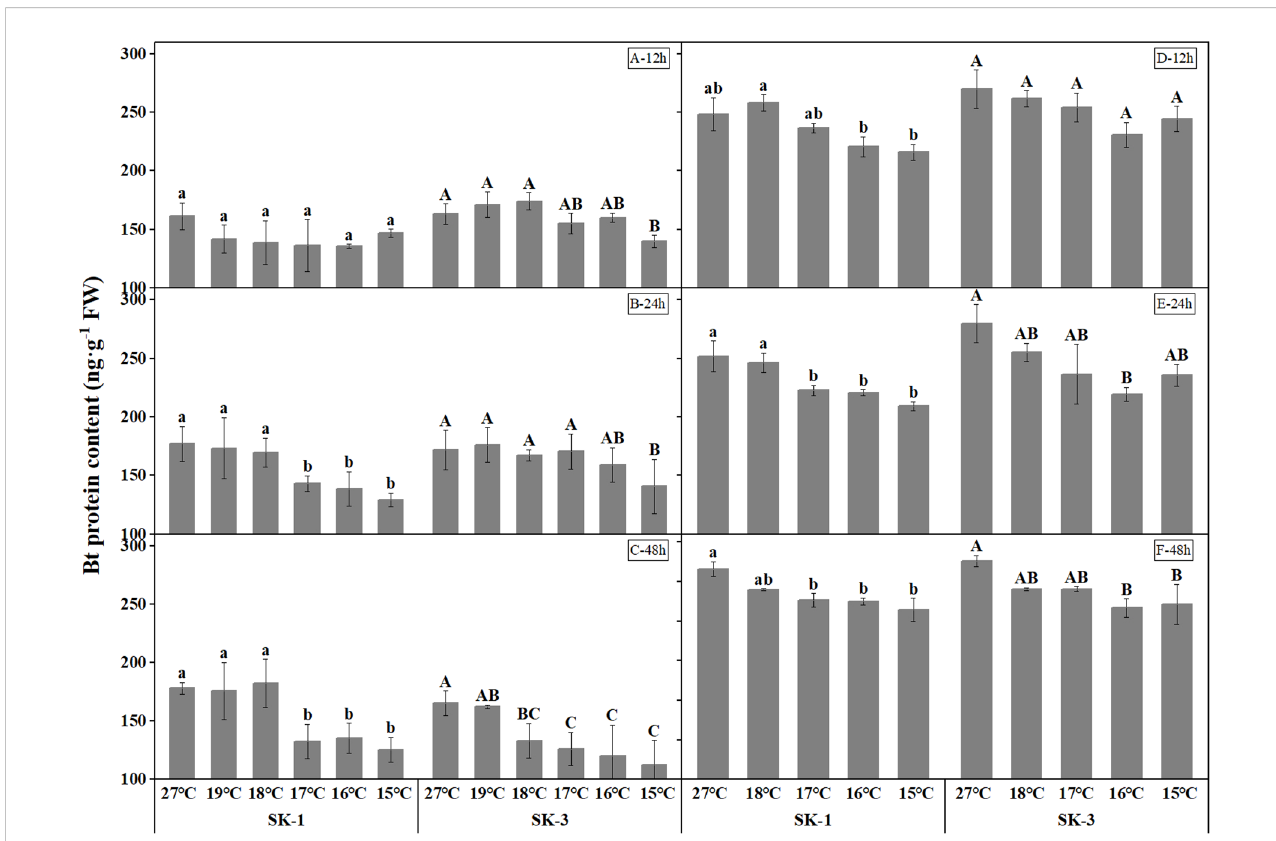
FIGURE1 Effect of low temperature stress on Bt insecticidal protein content in cotton squares in 2020 ( A-C : 12h, 24h, 48h stress) and 2021 ( D-F : 12h, 24h, 48h stress). FW represents fresh weight. Different lowercase letters indicate the signi fi cant differences between the treatments of the variety SK1, and different capital letters indicate the signi fi cant differences between the treatments of the variety SK3